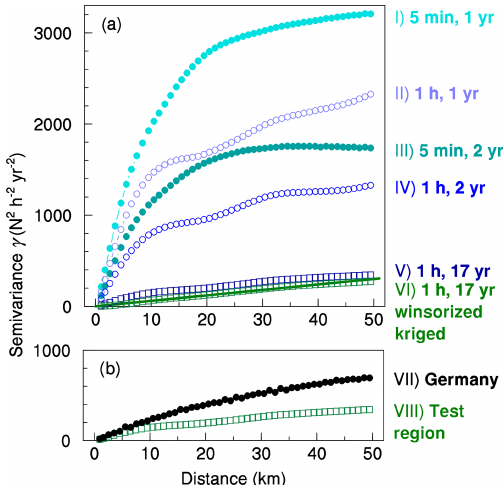
Figure 3. (a) Experimental semivariograms of annual erosivity of the test region for different temporal resolutions of rain data (5min and 1h), different averaging (1 year, 2011 + 2012; 2 years, mean of 2011 and 2012; 17 years, 2001 to 2017), winsorizing and kriging (for selected distance classes see Table 1). The line through semivar- iogram VI is a linear regression through the origin ( r 2 = 0 . 9889). (b) Comparison of semivariances for the 1h, 17-year and win- sorized data before kriging for the test region and for the whole of